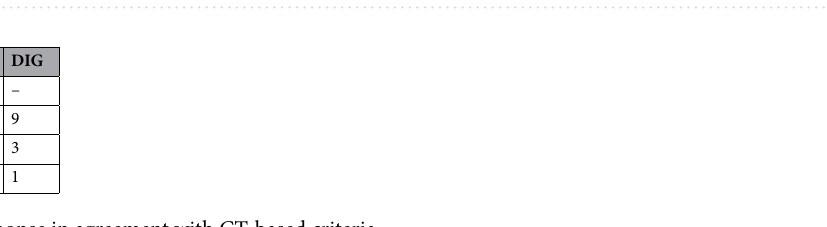
Figure 7. Kaplan–Meier estimates of event free survival (EFS) between CIG and DIG. No different EFS was detect between CIG and DIG patients obtained CMR (75% vs 77% Logrank test p = 0.95) (75% vs 77% Logrank test p = 0.95).